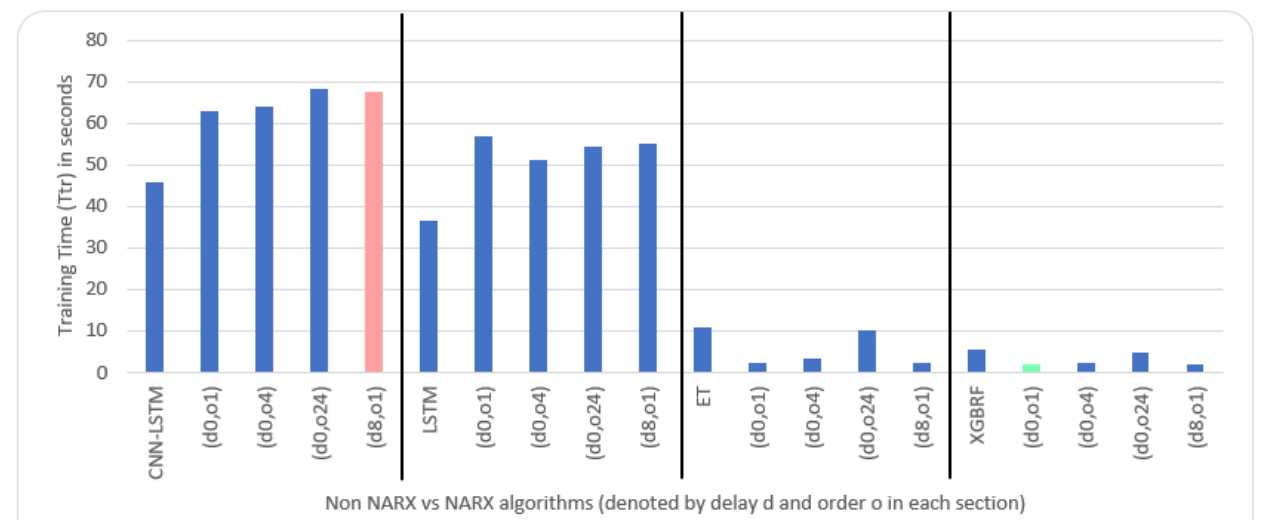
Figure 30. Evaluation results of non-NARX and NARX in terms of normalised root mean square error for the Manchester dataset.